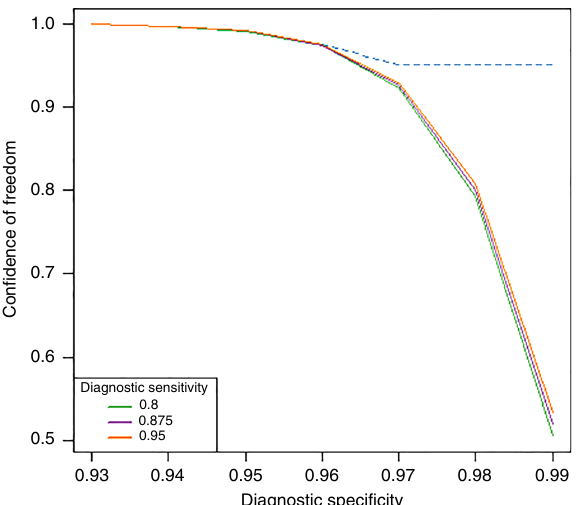
Fig. 3 Power of a survey to declare infection freedom in a population. The solid lines depict the change in the power of an infection freedom survey (in the form of con fi dence for declaring freedom) as the speci fi city of the diagnostic test used increases to 0.99 for three fi xed sensitivity values (Se = 0.8, 0.875, and 0.95) and fi xed survey sample sizes. The results show the dramatic decline in the power of a survey to declare infection freedom as diagnostic test speci fi city increases from 0.95 towards perfect speci fi city, whereas increases in sensitivity for a given speci fi city value has only a slight effect. The dotted line shows that the power of the survey can be maintained even at high speci fi cities by changing the sample size. As test speci fi city increases (for a given sensitivity), con fi dence of a survey to declare infection freedom can only be maintained at high levels (> 95%) by increasing sample sizes signi fi cantly. In the present example, which is based on the 2011 survey results from Bunabutiti (Table 1), the required sample sizes to maintain this high con fi dence for declaring freedom from onchocerciasis (dotted line) work out to be 123 at Sp = 0.96 to as high as 650 at Sp =